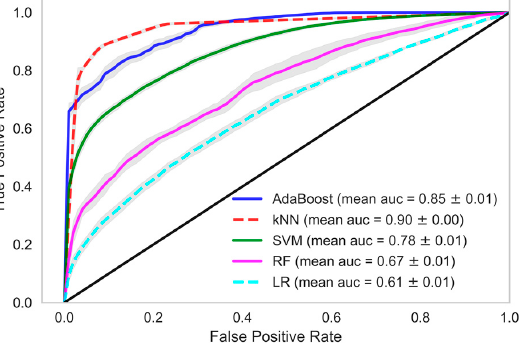
Figure 2. Receiver Operating Characteristics plot showing mean area under curve of all the classifiers of Model-1 when all HD sessions were considered.